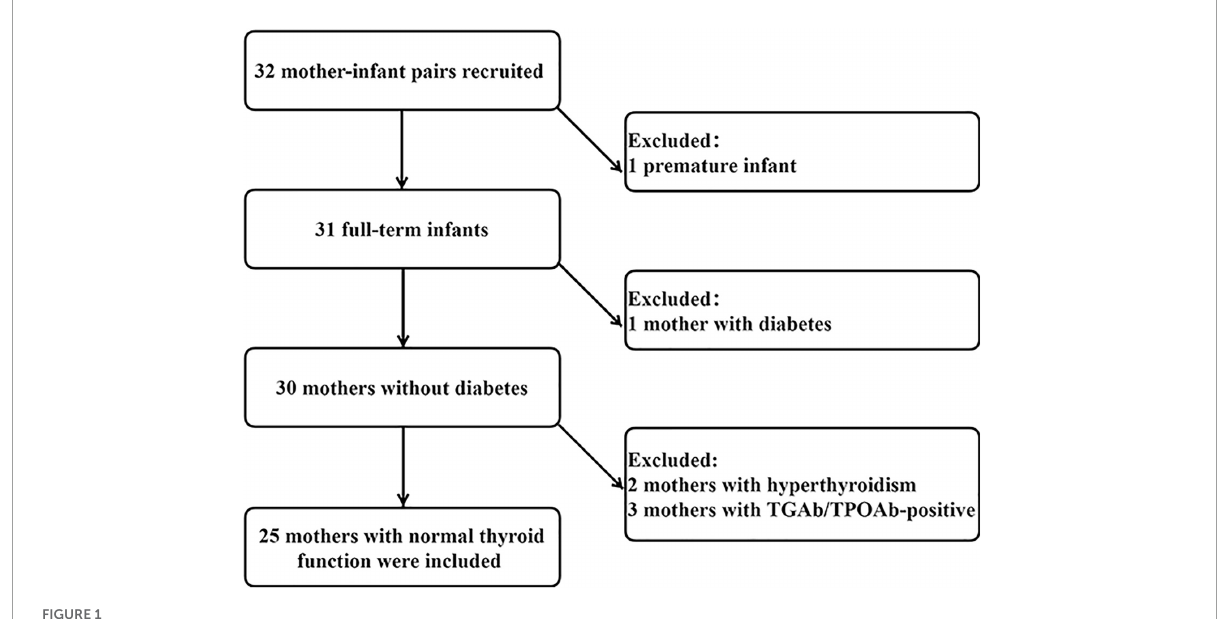
FIGURE1 Flowchart of the